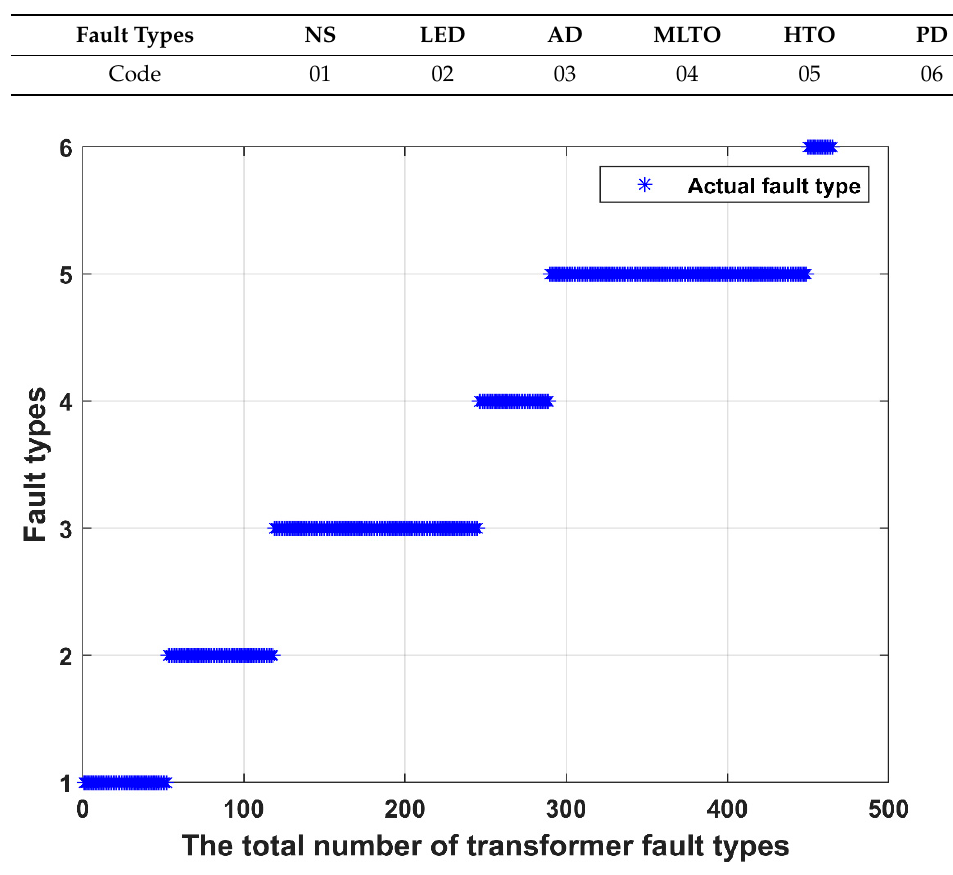
Figure 7. The sample distribution of the transformer fault types.